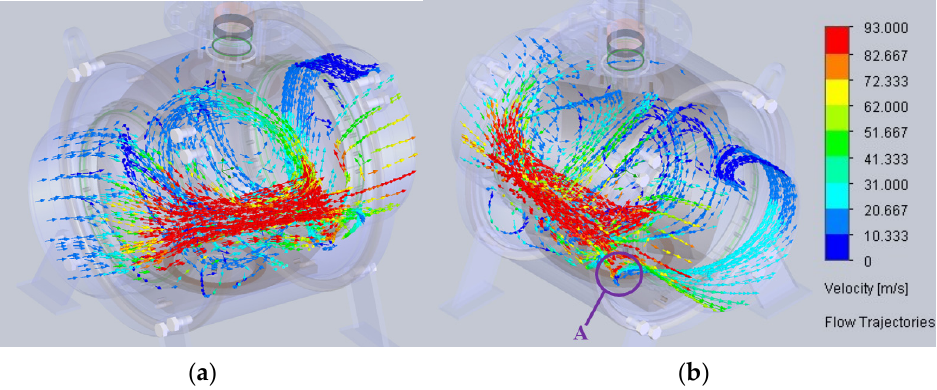
Figure 11. Velocity line trajectories for a 70° closure angle: ( a ) upstream view; ( b ) downstream view.